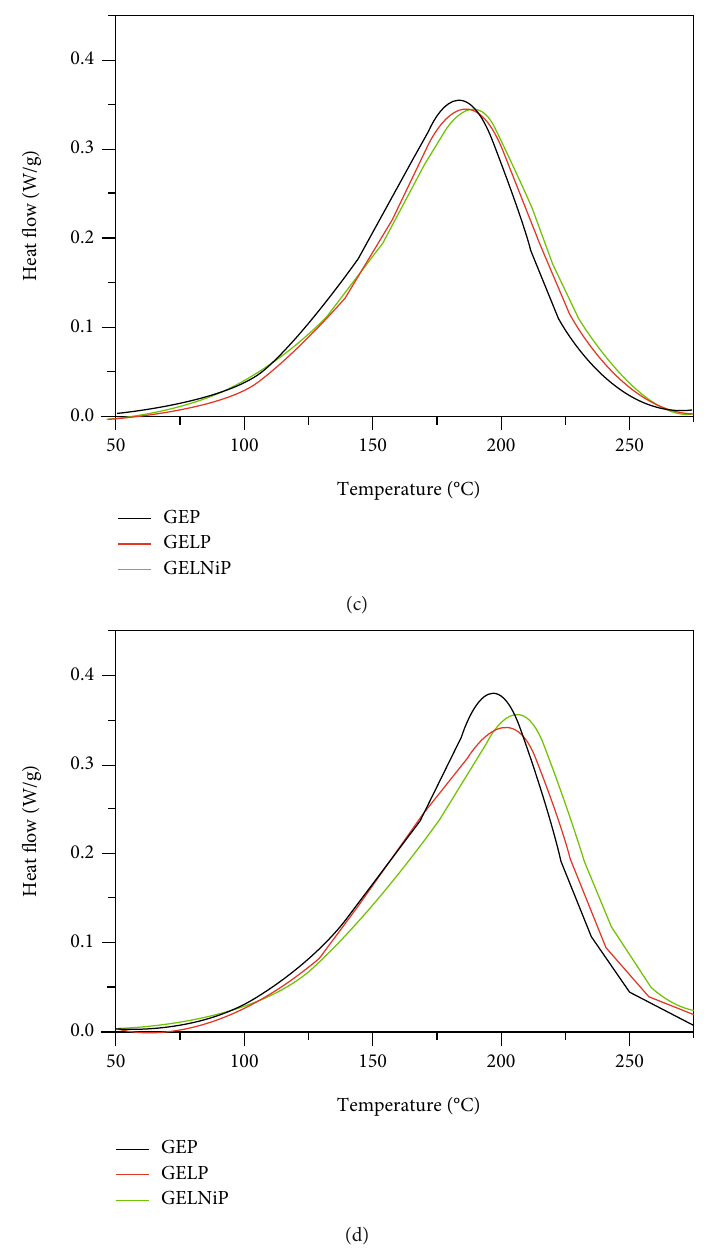
Figure 3: Cure state of GEP and GELP and GELNiP nanocomposites at heating rates of (a) 5, (b)10, (c) 15, and (d) 20 °